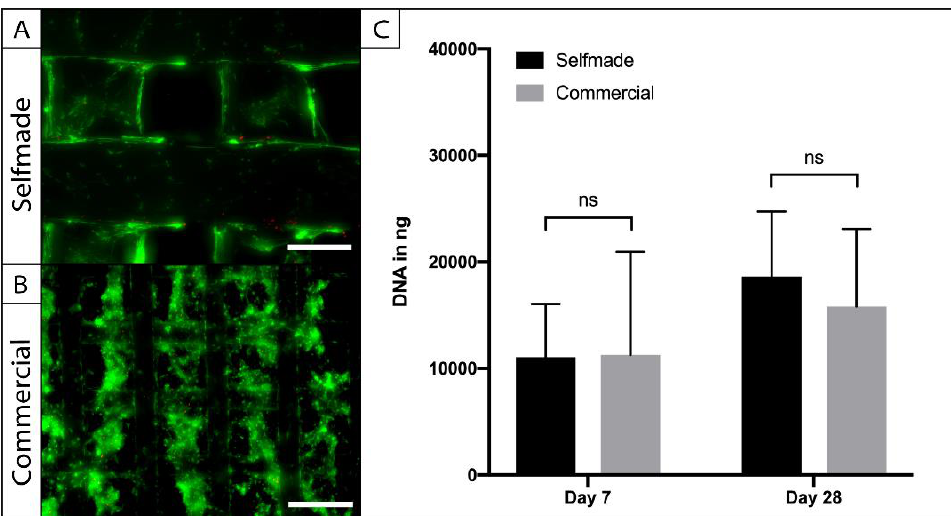
Figure 4. Testing for biocompatibility. ASCs were seeded on the self-made ( A ) and the commercial ( B ) scaffolds and were visualized by Live – Dead assay. Vital cells were stained in green (FDA) and dead cells are displayed in red (PI). Cell viability and adherence was comparable on the different PCL-scaffolds (A, bar = 200 µm; B = 300 µm). Absolute cell number and proliferation were evaluated with a PicoGreen assay ( C ). No statistic signifances of ASC-DNA content could be found between the compared scaffolds ( n = 5; ns = not significant; mean ± SD).